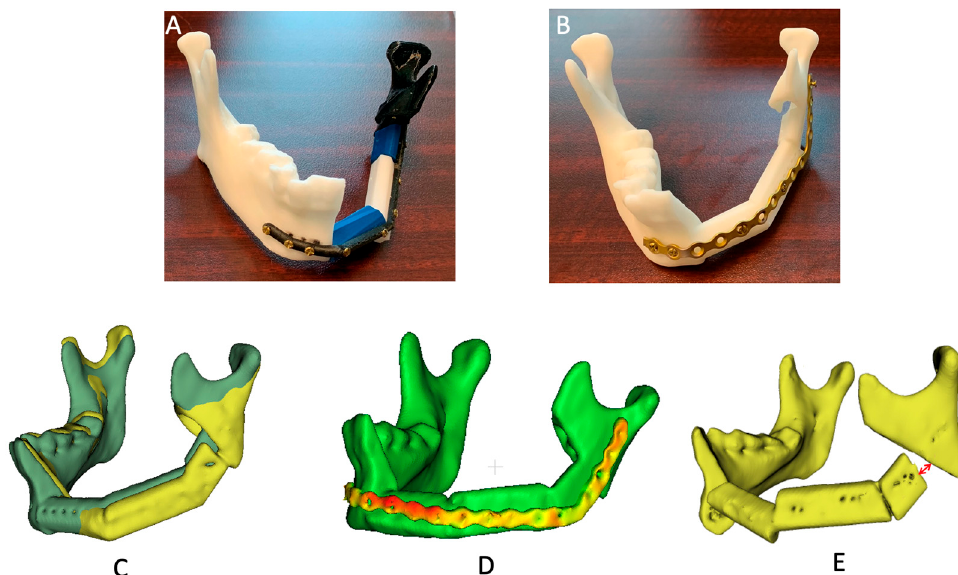
Figure 1. Reconstructions and structural accuracy variables. ( A ) Reconstruction with a customized, patient-specific, pre-printed plate. ( B ) Reconstruction with a manually contoured plate. ( C ) Volumetric overlap and Hausdorff-95 between reconstruction (yellow) and plan (green) were measured in 3D Slicer. ( D ) Distance between reconstruction plate and mandible was measured in CloudCompare. ( E ) Distance at each apposition was measured in 3D Slicer (red arrow).